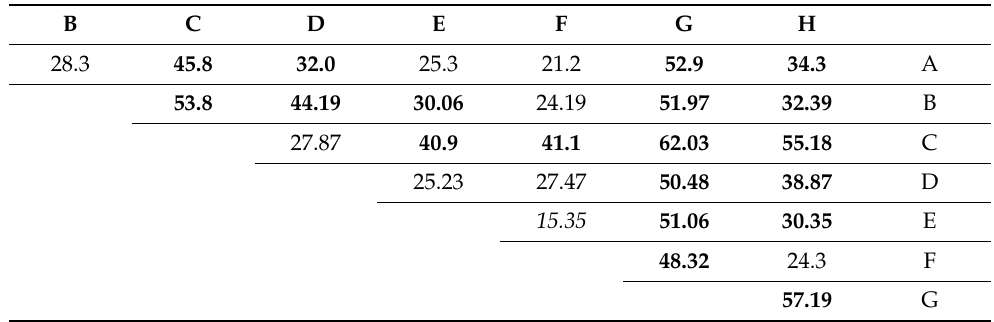
Table 10. Values of %GRR